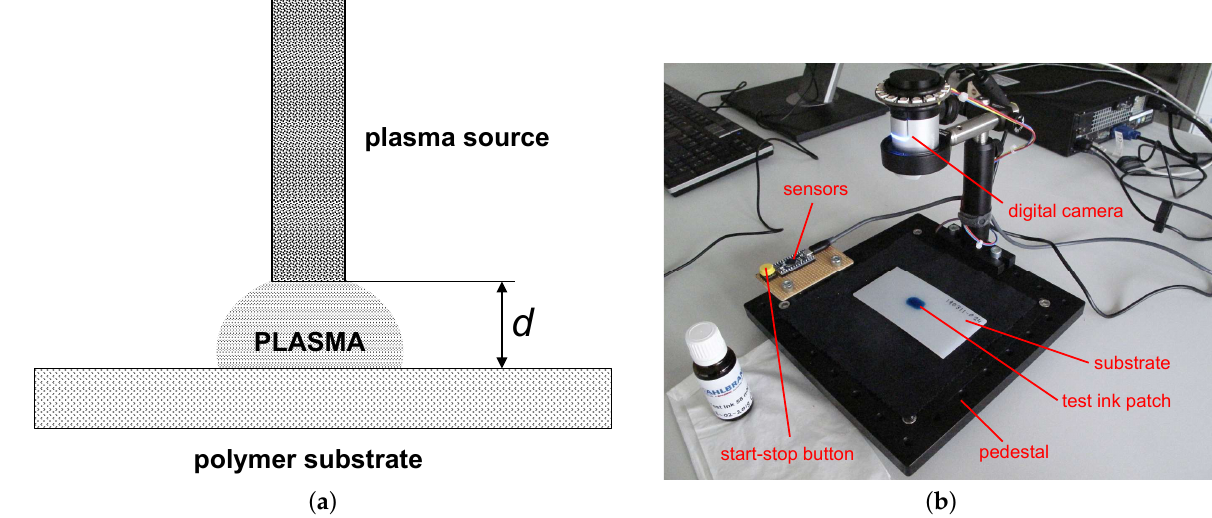
Figure 2. Experimental setup. ( a ) Generic setup for activation of the polymer substrate surface. The meaning of d depends on configuration A–G as defined in Table 1. ( b ) Picture of setup for